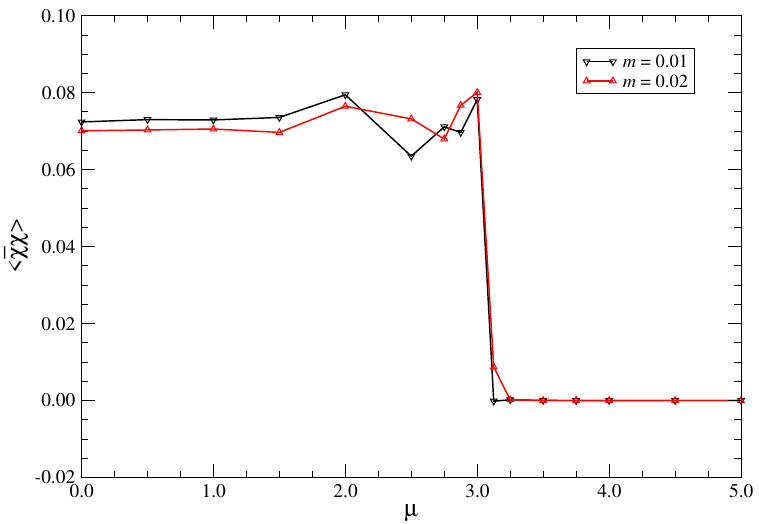
Figure 6 . Chiral condensate at m = 0 . 01 and 0 . 02 on 1024 4 lattice as a function of µ with D = 55 . evaluated